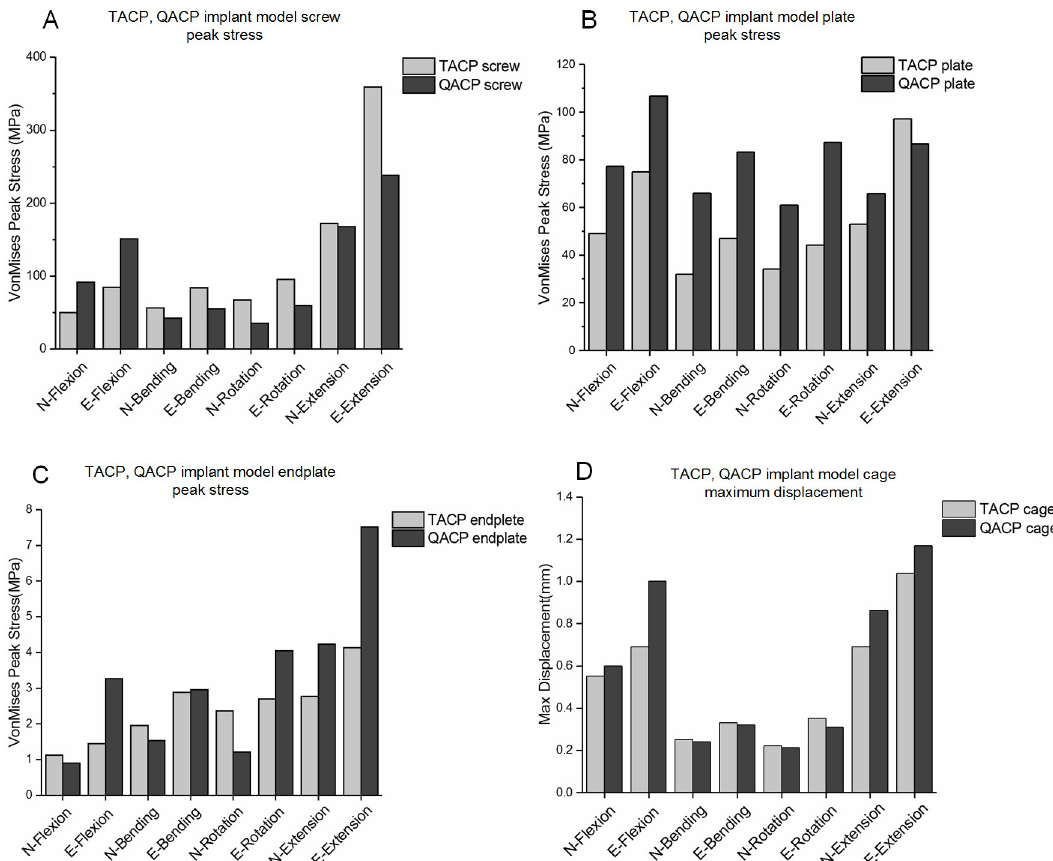
Fig 4. Comparison of the peak stresses in screws, plates, and endplates between triangle anterior cervical plate (TACP) and quadrilateral anterior cervical plate (QACP) systems undergoing normal and excessive motion, and the maximum cage displacement. N, normal postoperative motion; E, excessive postoperative motion. (A) TACP and QACP screw. (B) TACP and QACP cervical plate. (C) TACP and QACP C5-C6 endplate. (D) TACP and QACP